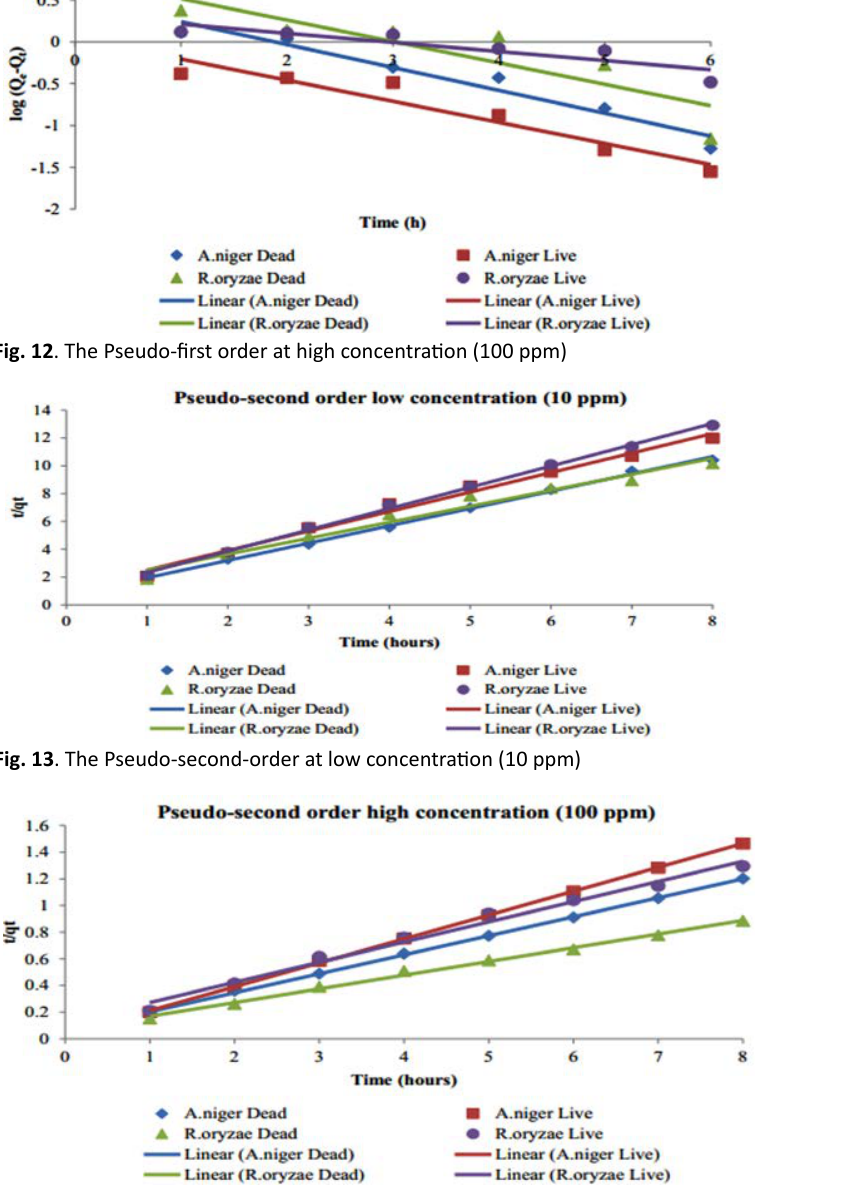
Fig. 14 . The Pseudo-second-order at high concentration (100